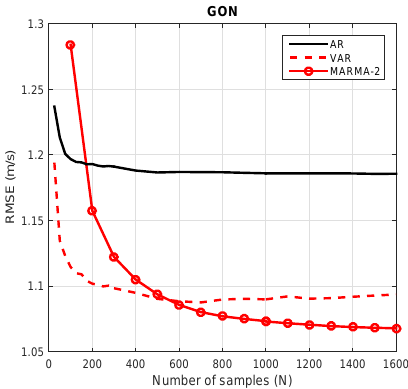
Figure 10. RMSE performances of the AR, VAR and MARMA models with respect to number of previous samples N when m = 3 (GONEN) and ∆ = 2 h.